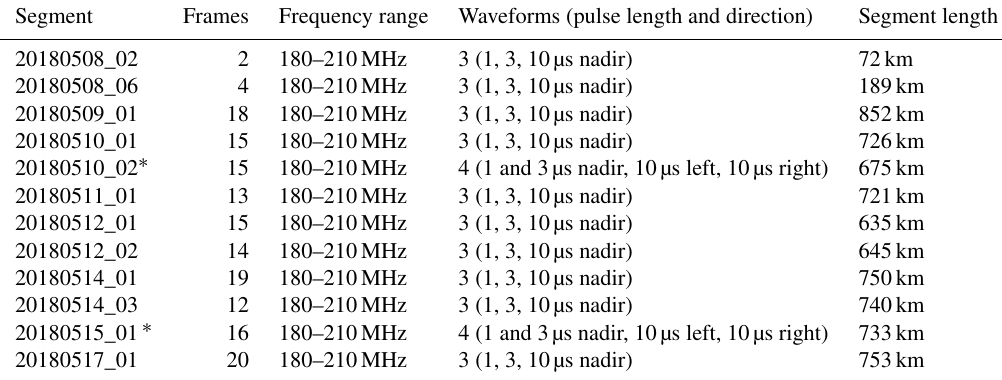
Table A1. Radar profile specifications of each segment.